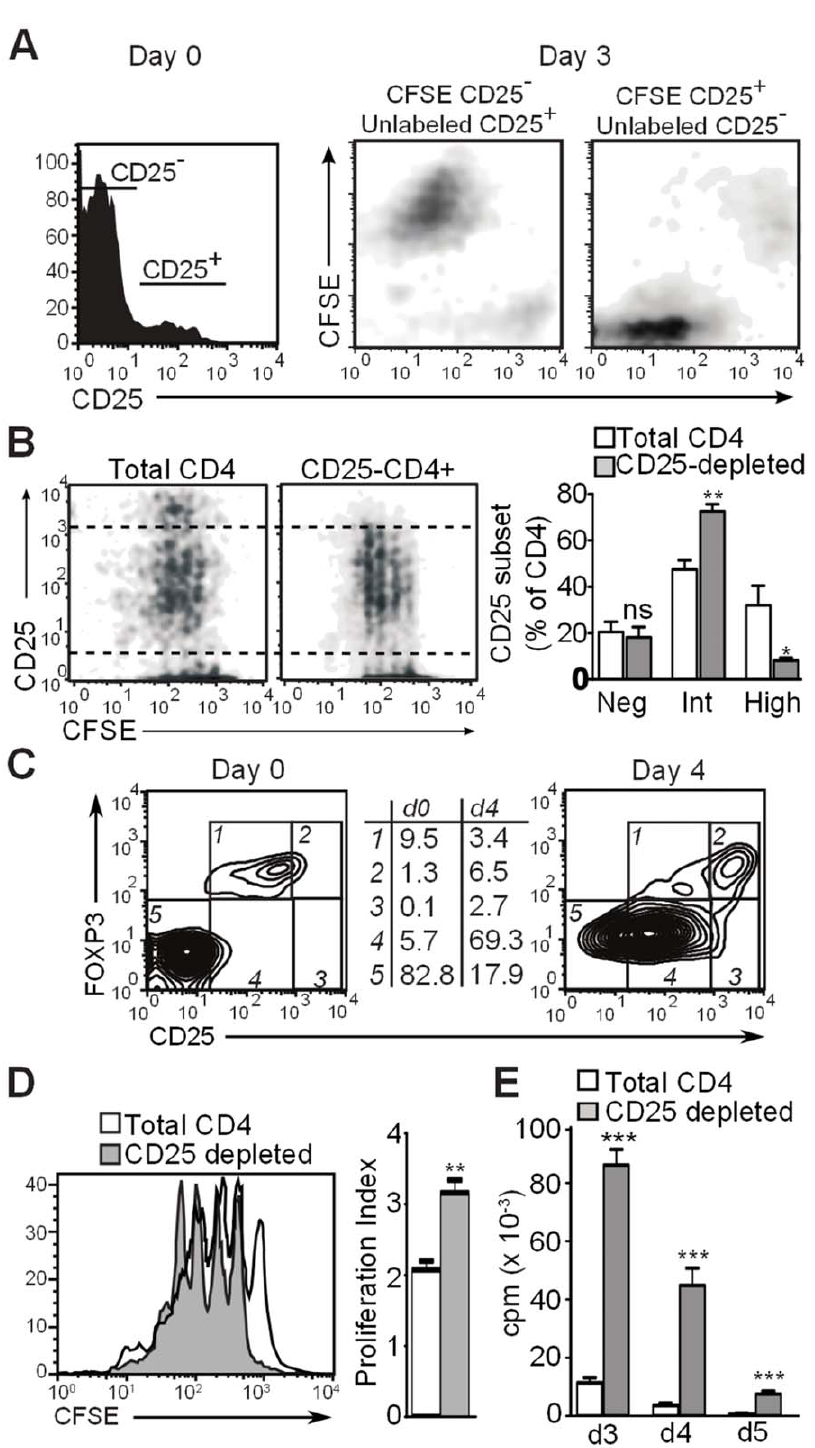
Figure 5. CD25 High CD4 + T cells originate from natural CD25 + CD4 + T cells. ( A ) Histogram showing CD25 expression pattern of unstimulated CD4 + T cells (day 0; top). Isolated CD25 2 and CD25 + CD4 + T cells were co-cultured in a cross-over setup with only one of the subsets carrying CFSE label. Three days after stimulation with 0.1 m g/ml anti-CD3 mAb and irradiated TdAC, CD25 expression and CFSE dye dilution were measured using flow cytometry and displayed as density plots (bottom). ( B ) CFSE-labeled total CD4 + T cells (top) or CD25 + -depleted CD4 + T cells (bottom) were stimulated as in ( A ). Shown are flow cytometry density plots of CFSE dye dilution versus CD25 expression gated on viable CD4 + T cells. Percentages indicate the percentage of CD25 High or CD25 Int cells within all CD25 + positive CD4 + T cells. ( C ) Contour plots showing CD25 versus Foxp3 expression of unstimulated and day 4-stimulated CD4 + T cells. Numbers on the right reflect the percentages within the gates 1–5, gated on viable CD4 + T cells. ( D ) CFSE-labeled total CD4 + T cells (shaded) or CD25 + -depleted CD4 + T cells (solid line) were stimulated with anti-CD3 (0.1 m g/ml) and irradiated TdACs for 3 days. Shown are histogram overlays gated on viable CD4 + T cells and bar graph of proliferation index mean 6 SEM. ( E ) Total CD4 + T cells or CD25-depleted CD4 + T cells were stimulated with anti-CD3 (0.1 m g/ml) and irradiated TdACs for indicated time and proliferation was measured via